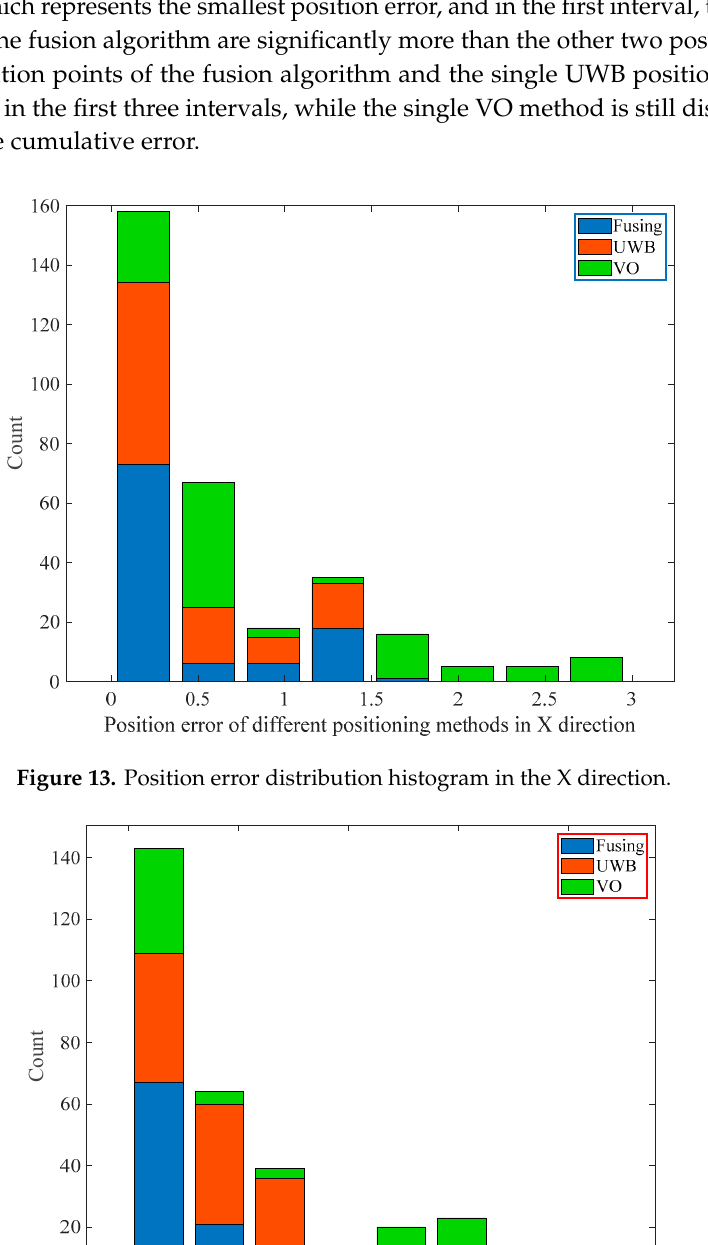
Table 3. Percentage of location points in the y direction.